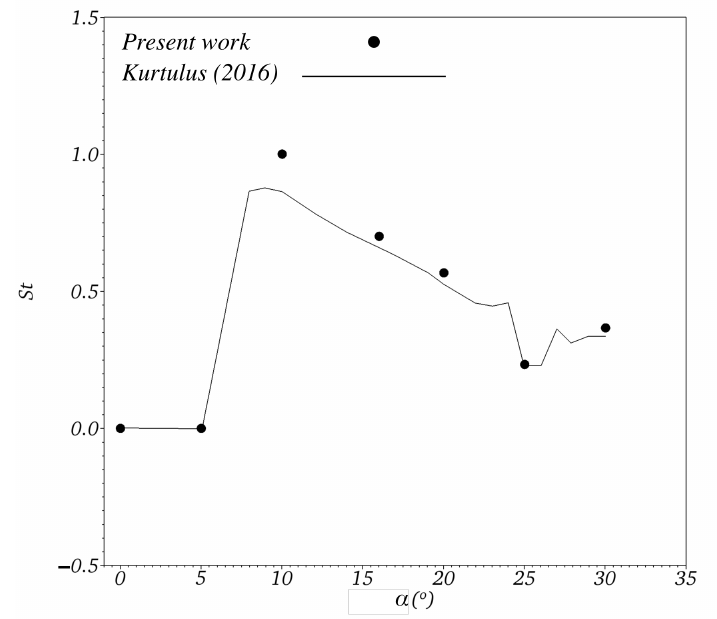
Figure 14. Variation of St as a function of α